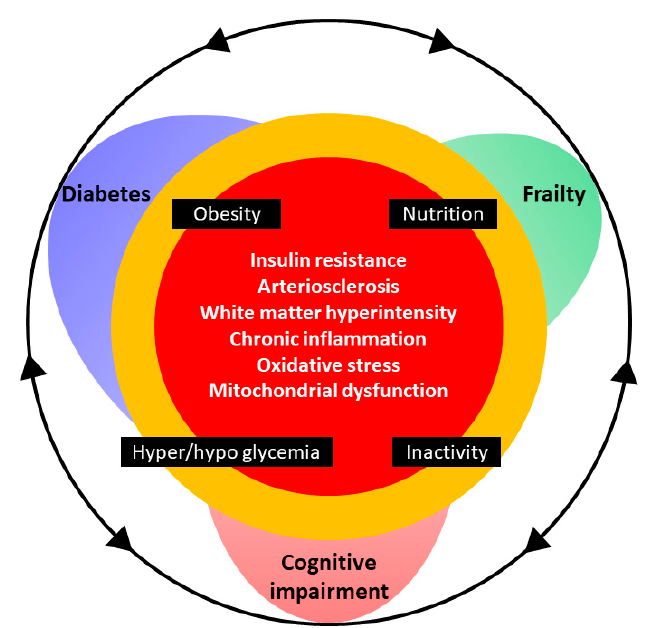
Figure 1. Cognitive impairment and frailty in older adults with diabetes. The mechanisms of diabetes, frailty, and cognitive dysfunction are closely related in the context of aging. Insulin resistance, arteriosclerosis, chronic inflammation, oxidative stress, and mitochondrial dysfunction are integrally involved in the pathogenesis of cognitive impairment, frailty, and diabetes mellitus. Obesity, inappropriate nutrition, physical inactivity, hyperglycemia, and hypoglycemia can be risk factors for cognitive impairment and frailty in older adults with diabetes. Proper management of body weight, nutrition, and exercise together with optimal glycemic control are the cornerstones of good health.